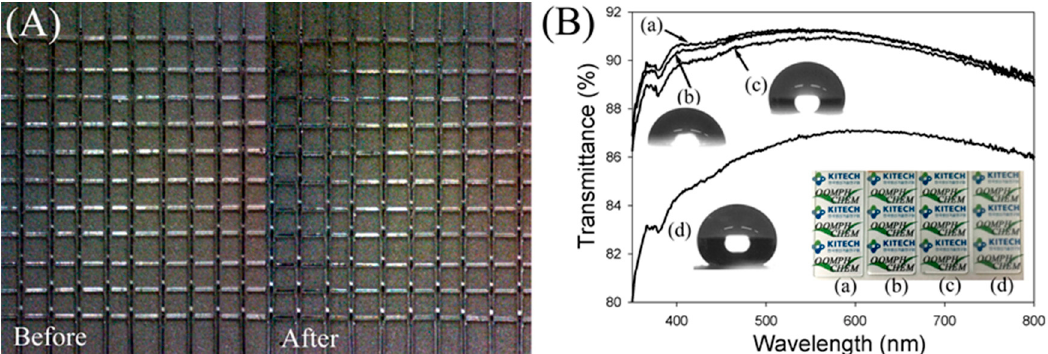
Figure 11. ( A ) Optical images of the cross-cut substrates before and after peeling off the tape and ( B ) transmittance spectra and optical images of glass slides spray-coated with 12 nm-SiO 2 (46)@PFMA with different concentrations; (a) bare glass slide, (b) 0.5 wt%, (c) 1 wt%, (d) 2 wt%. The insets are hexadecane droplet shapes for (b), (c), and (d).